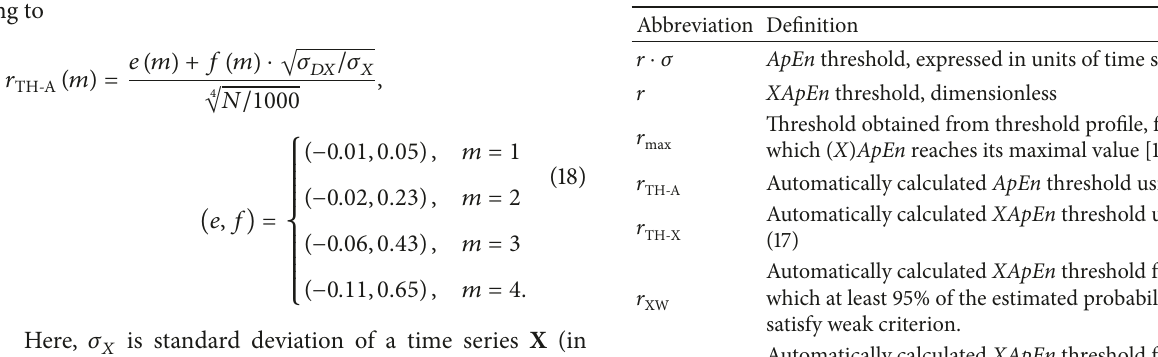
Table 1: Threshold abbreviations and